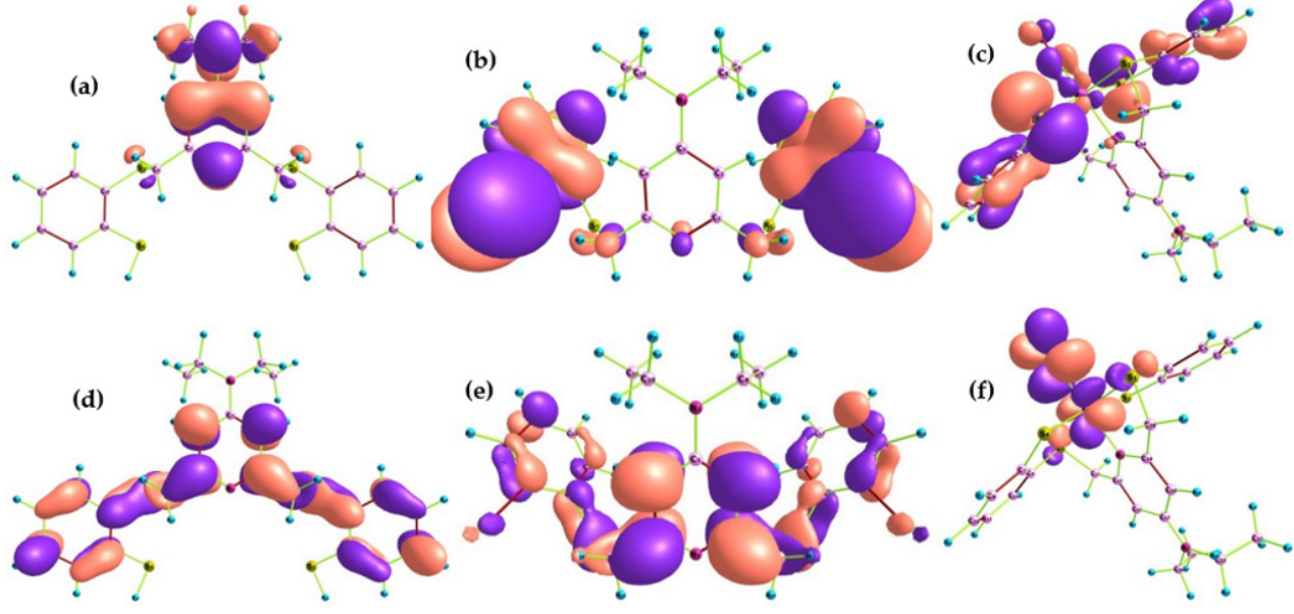
Figure 3. HOMO of ( a ) TSPH 2 , ( b ) TSP 2 − , and ( c ) [RuNOTSP] + and LUMO of ( d ) TSPH 2 , ( e ) TSP 2 − , and ( f ) [RuNOTSP] + .